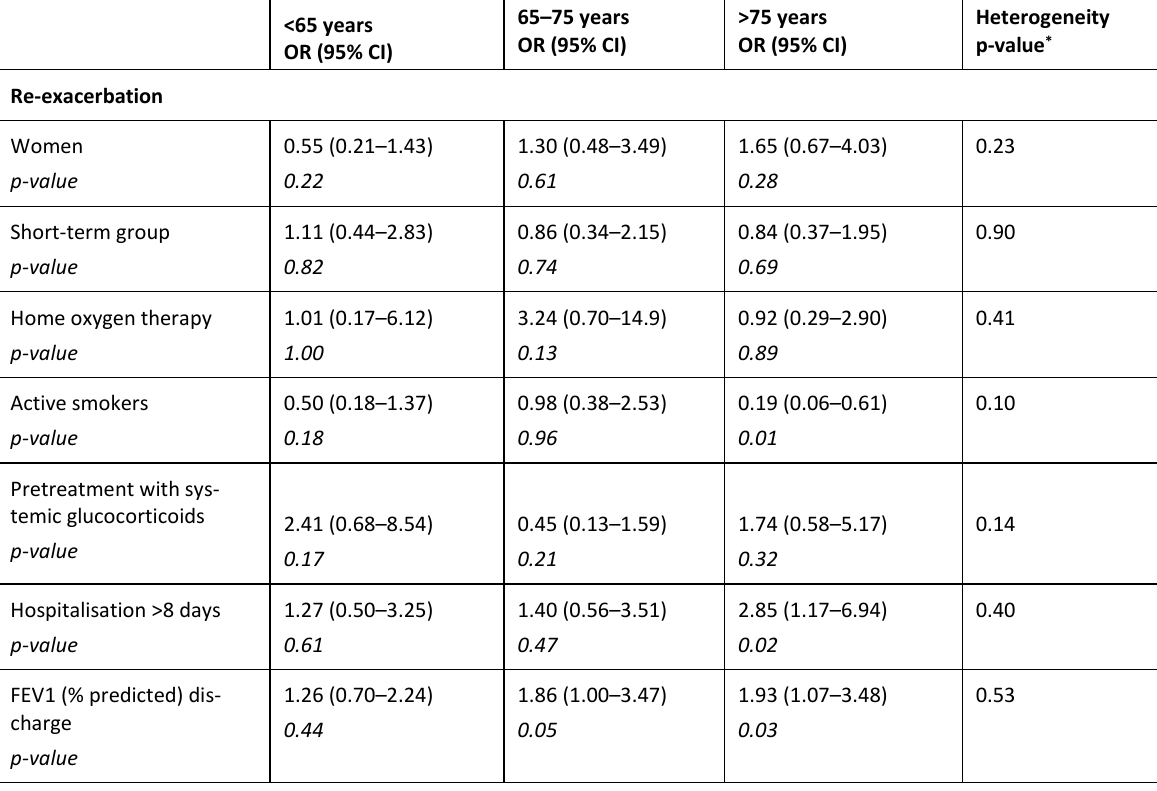
Table S2B: Multivariate analysis of re-exacerbation or re-exacerbation and/or death stratified by age at